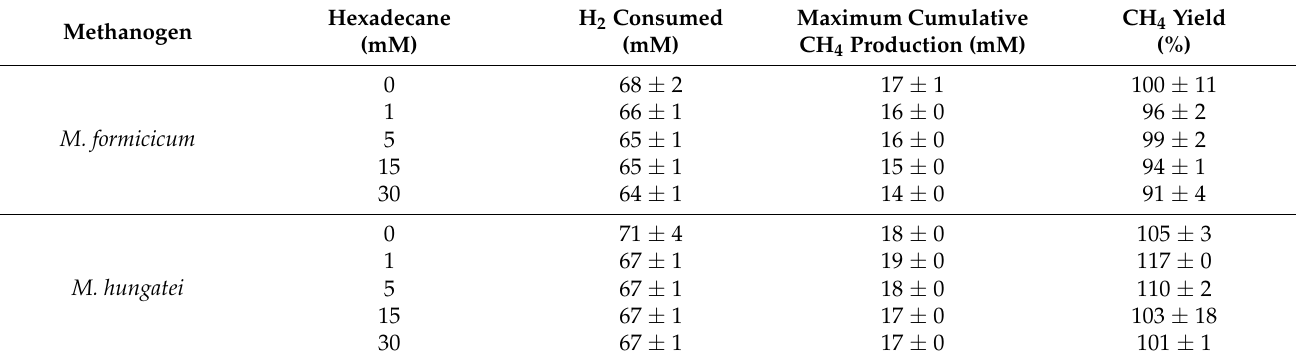
Table 2. Total hydrogen consumed, maximum cumulative methane produced, and calculated methane yields for the incubations of M. formicicum and M. hungatei , with increasing hexadecane concentrations. The values represent the average of triplicates ± standard